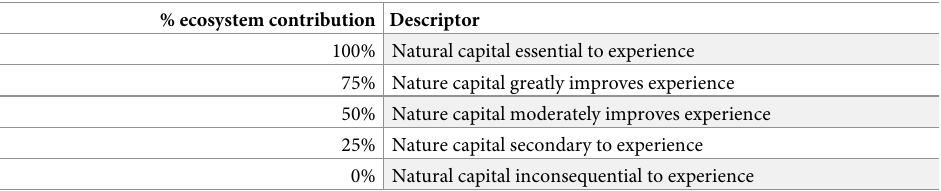
Table 1. Ecosystem attribution scoring